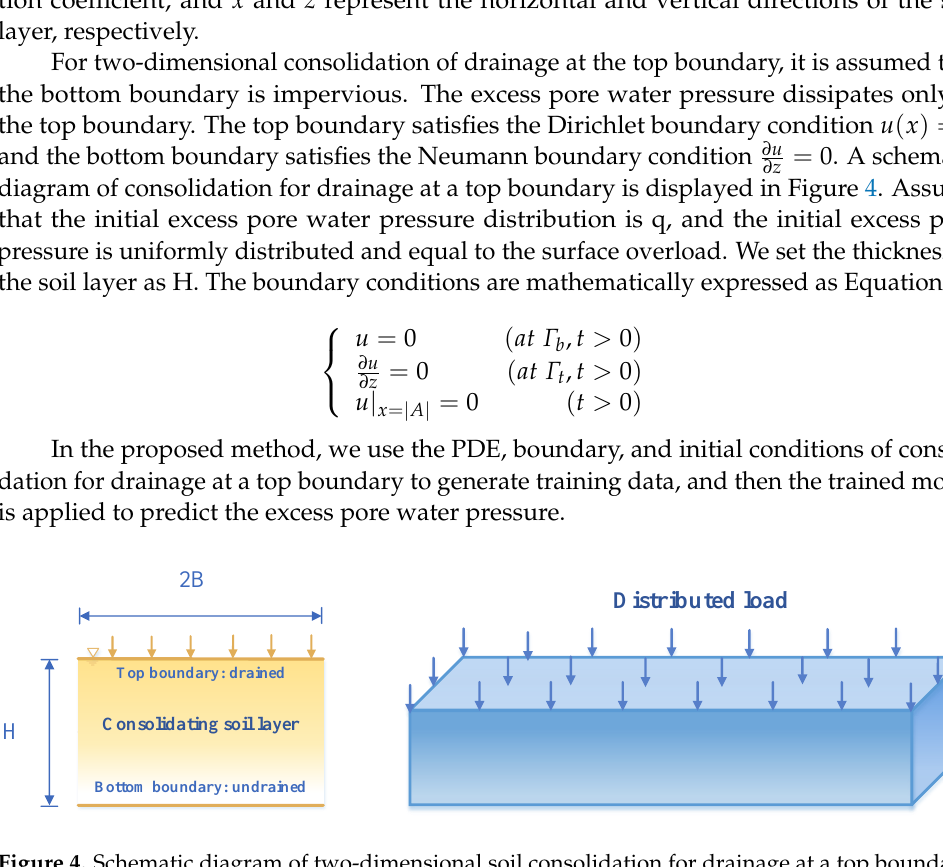
Figure 4. Schematic diagram of two-dimensional soil consolidation for drainage at a top